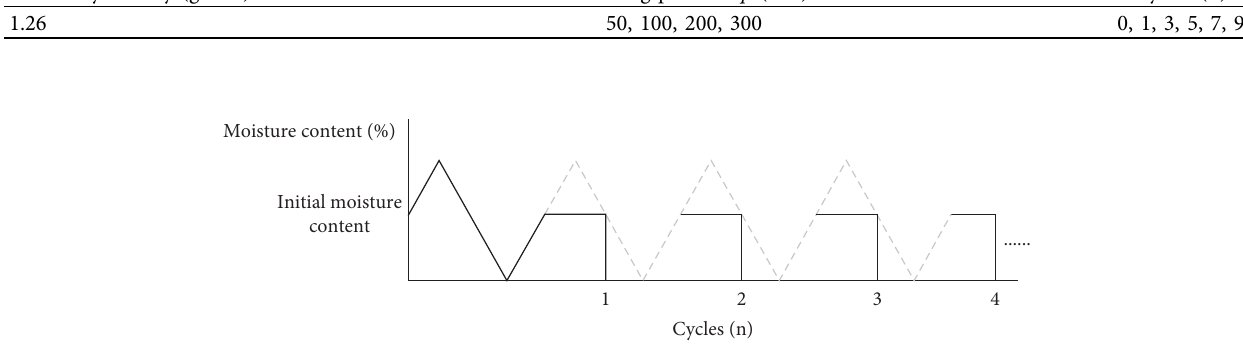
Figure 2: Schematic diagram of dry and wet